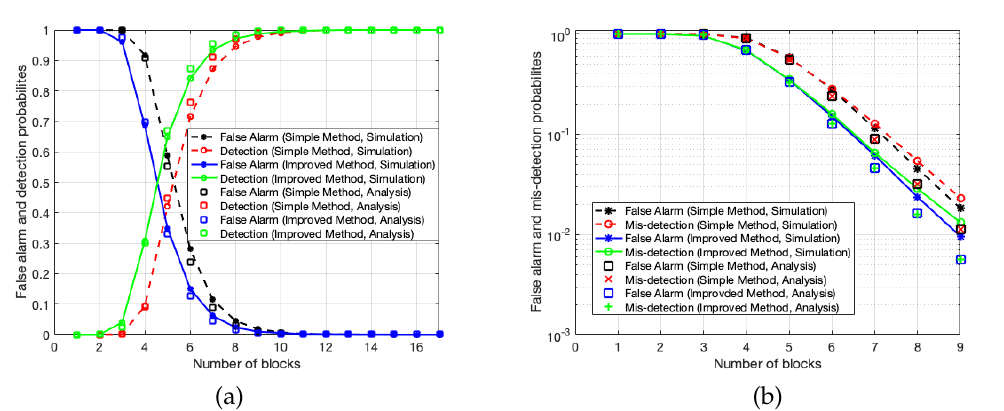
Figure 10. Interference detection performance of simple and improved approaches with respect to the number of blocks, L , when interference power is –23 dB lower than the desired signal, λ = 3 for the simple method and λ (cid:48) = 6 for the improved method: ( a ) False alarm and detection probabilities and ( b ) false alarm and misdetection